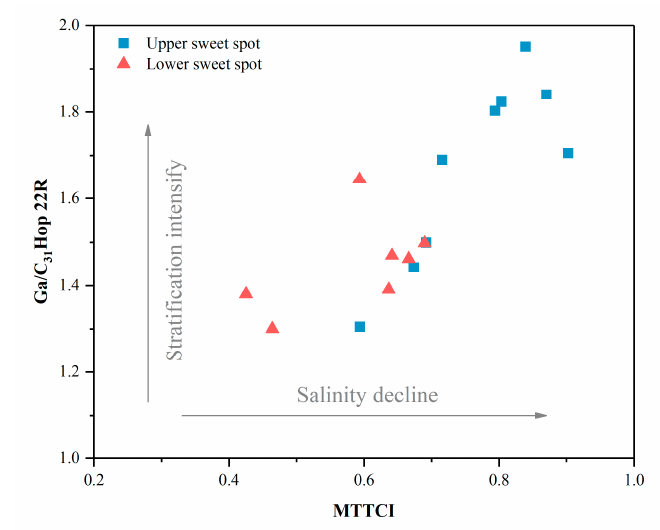
Figure 11. Positive correlation of gammacerane / C 31 22R hopane and MTTCI reflecting the relationship between water-column salinity and the stratification level.